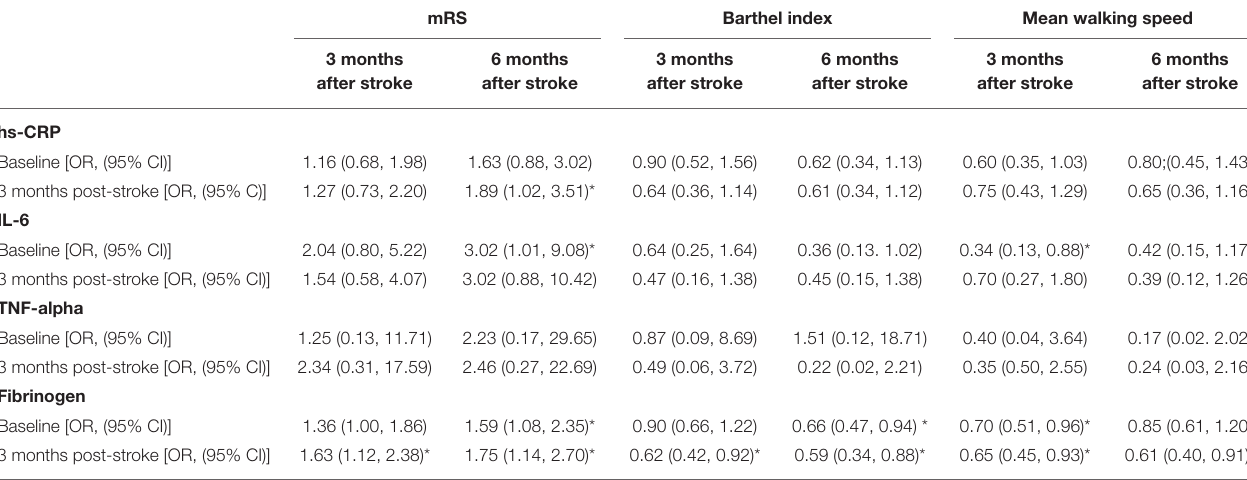
TABLE 3 | Associations of inflammatory biomarkers with outcome parameters in multivariate logistic regression models. mRS Barthel index Mean walking speed 3 months after